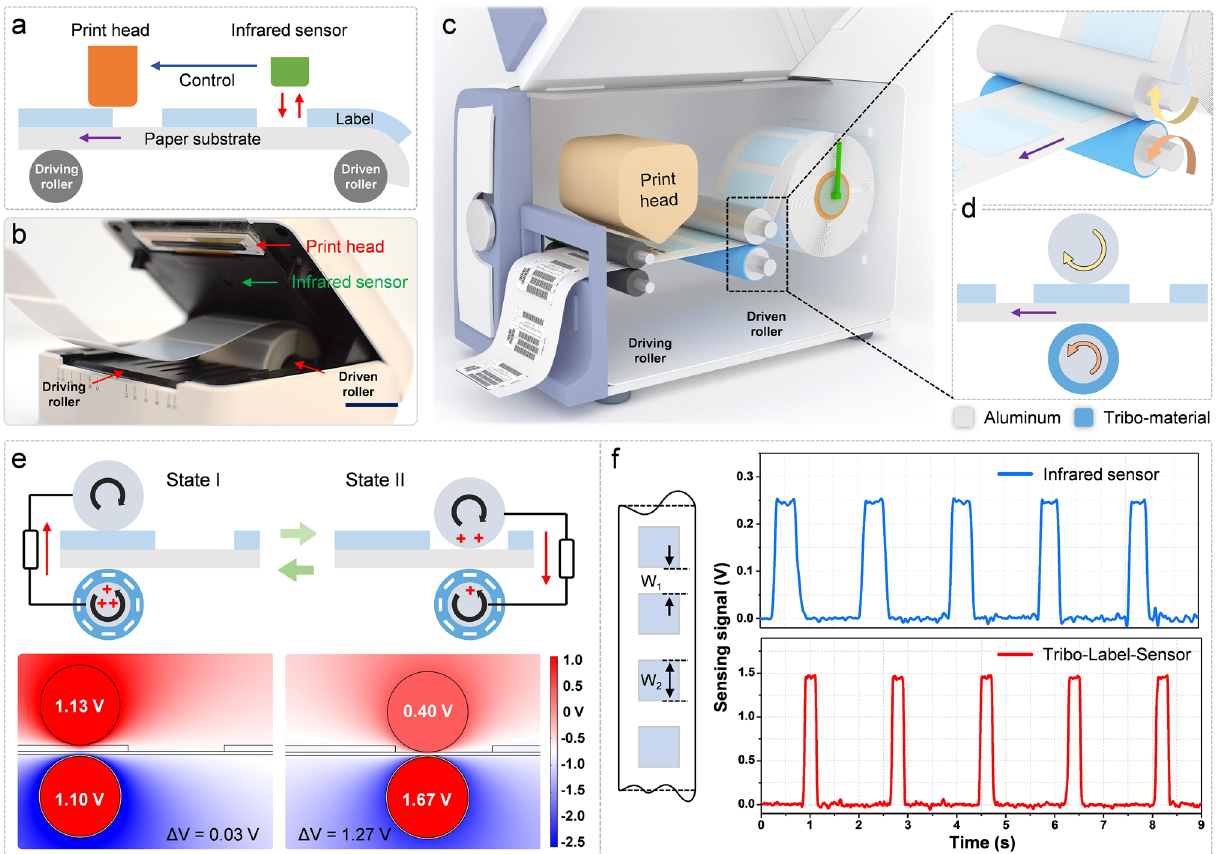
Fig. 1 Structure and sensing mechanism of the tribo-label-sensor (TLS). a Schematic of the basic components during label printing. b Optical photograph of a commercial portable label printer (scale bar: 2 cm). c 3D schematic inside a label printer embedded with TLS. d The detailed structure and working status of TLS. e Charge (Up) and simulated potential (Down) distribution of TLS in two typical states under short-circuit and open-circuit condition, respectively. f Output sensing signal comparison of infrared sensor and TLS. W 1 and W 2 in left schematic represent the interval between two labels and the label width,